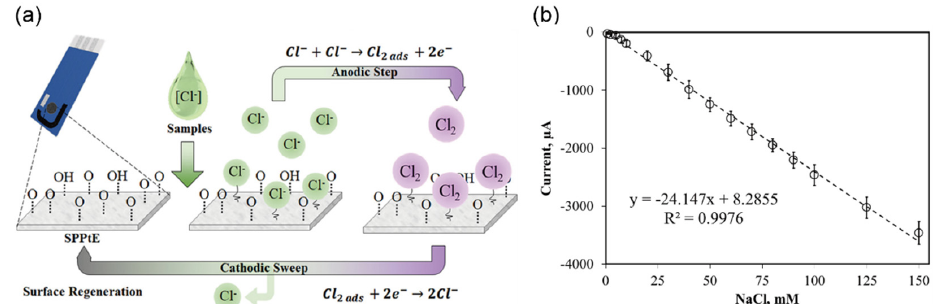
Figure 13. Selective detection of chloride ions in clinical samples ( a ) Schematic diagram showing the electrochemical mechanism for detecting chloride ions relying on the chloride complexation at the electropolished screen ‐ printed platinum electrode (SPPtE) surface. ( b ) Linear responses of the SPPtE sensor with chloride ion concentrations ranging from 0 to 150 mM, registered for seven distinct SPPtEs; the relative standard deviation (RSD) and sensitivity are 5.8% ( n = 7) and –24.147 µA/mM, respectively. (Reprinted with permission from Ref. [53]; copyright 2019, Elsevier.)